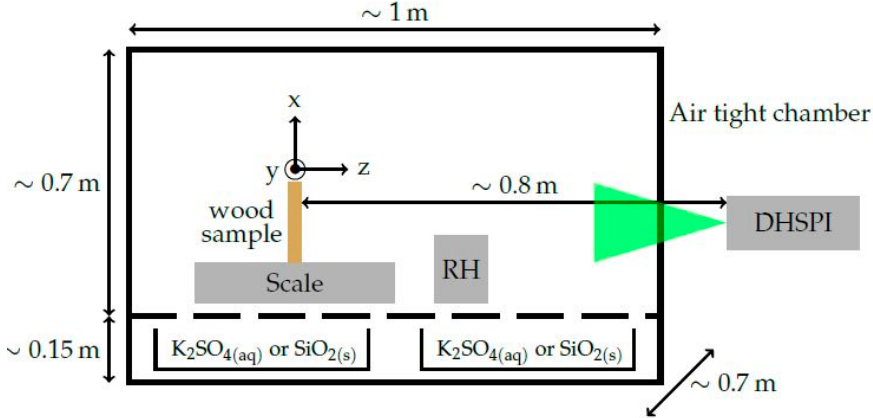
Figure 4. Schematic of the airtight climate chamber-DHSPI monitoring workstation.